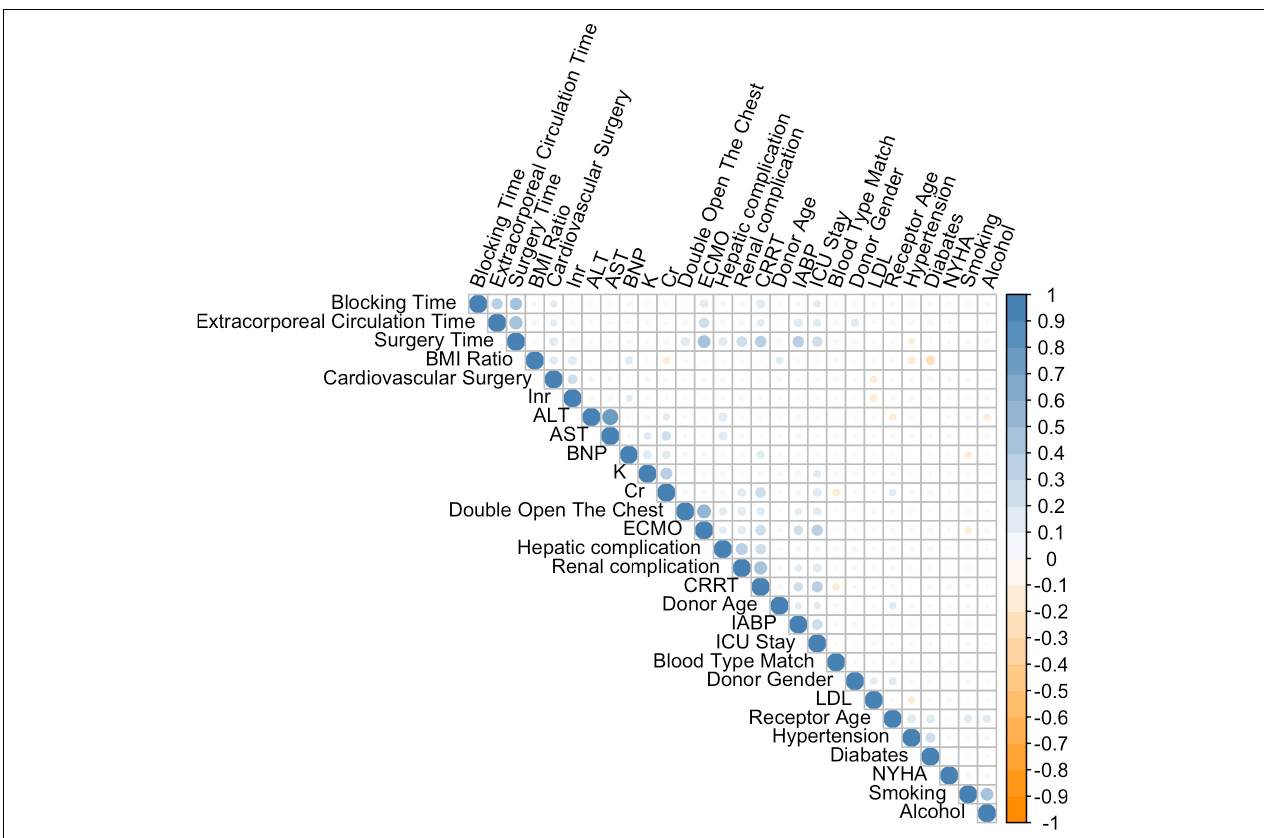
FIGURE 2 | Correlations among variables. The color scale ranges from blue (coefficient of 0) through white (coefficient of 0.5) to orange (coefficient of 1).